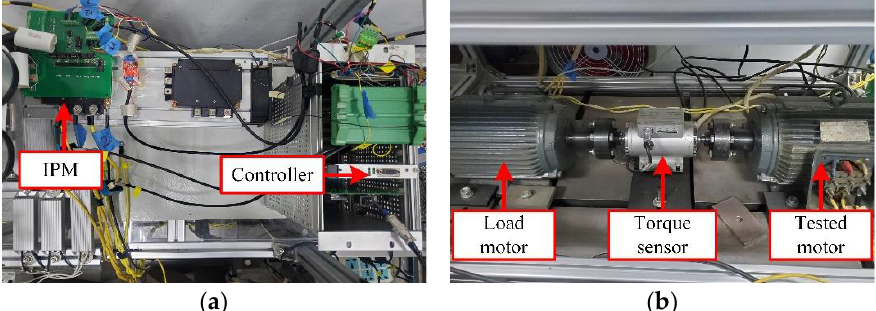
Figure 12. The physical picture of the experimental hardware platform: ( a ) controller and inverter. ( b ) Tested motor and load motor.